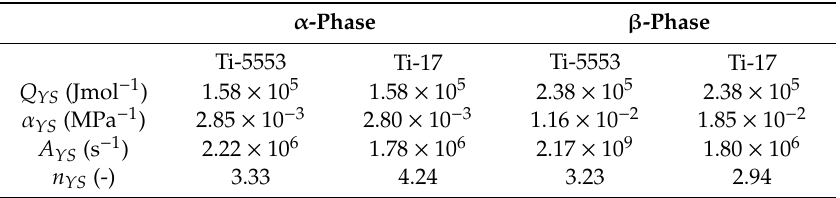
Table A5. Constants used for the calculation of the yield